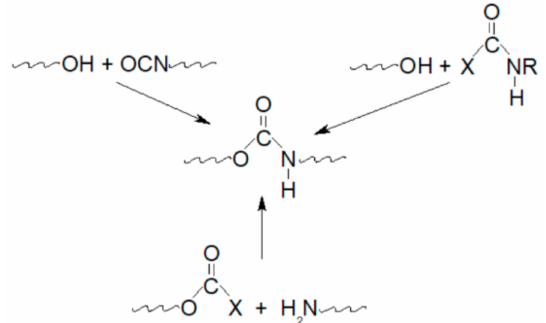
Figure 4. Schemes of the easiest ways to obtain urethane moieties (where X could be Cl, OR (cid:48) , NR (cid:48) R”, or SR (cid:48)